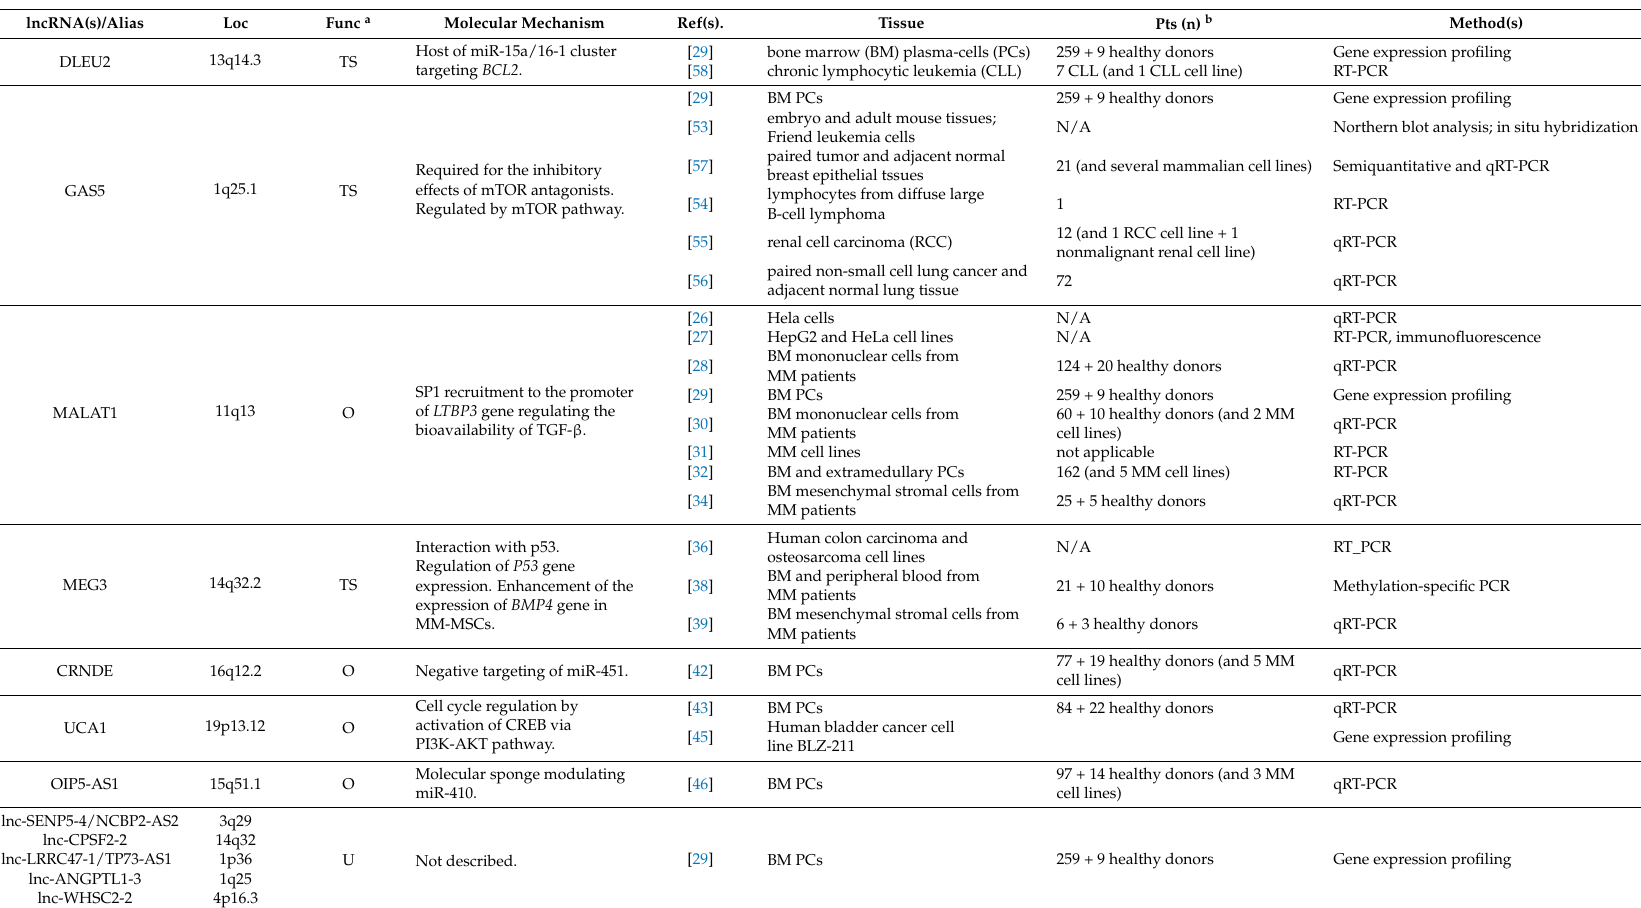
Table 1. Overview of selected lncRNAs with a putative pathogenetic role in multiple myeloma (MM). lncRNA(s)/Alias Loc Func a Molecular Mechanism Ref(s).